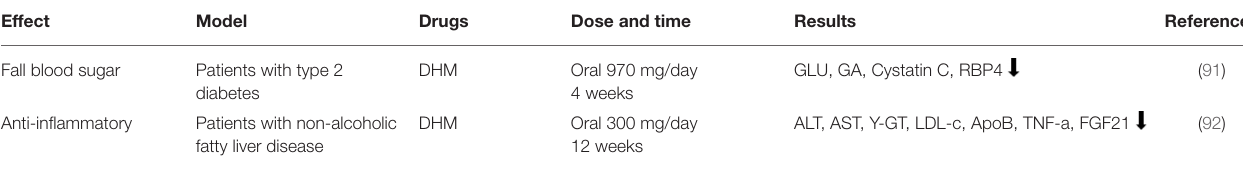
TABLE 3 | Effects of DHM on MS in the human